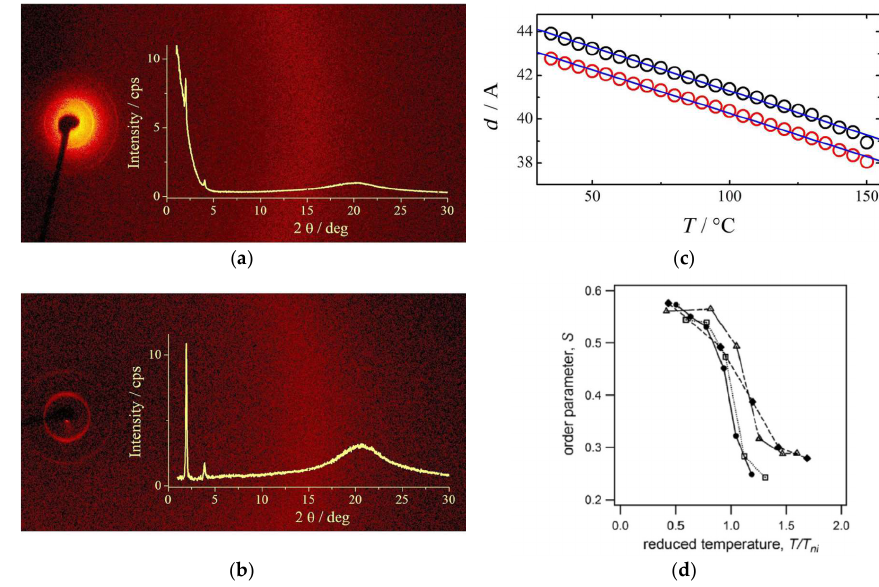
Figure 12. ( a , b ) Two-dimensional (2D) X-ray diffraction (XRD) patterns taken in the broad-angle range for smectic phases of polymers. ( a ) LCE-GNP with a hybrid gold-nanoparticle cross-linker; ( b ) standard LCE prepared with L3 as the cross-linker. ( c ) Temperature dependence of smectic-layer thickness for LCE-GNP (black circles) and LCE (red circles). Reproduced with permission from the authors of [68]. Copyright © 2018 Wiley Online Library. ( d ) Order parameter ( S ) as a function of the reduced